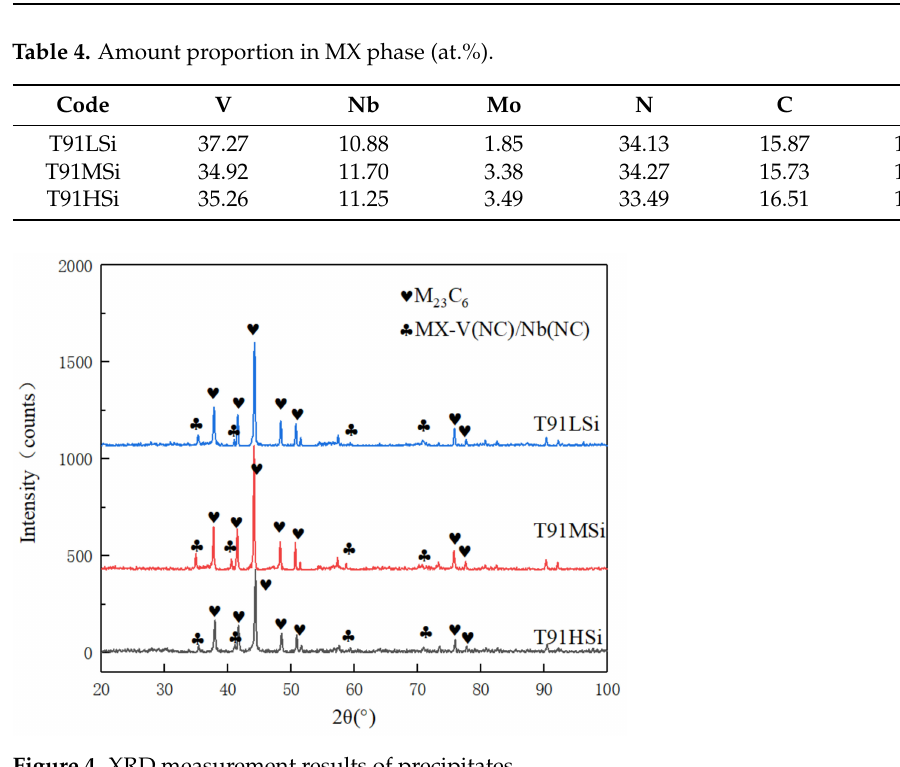
Figure 4. XRD measurement results of